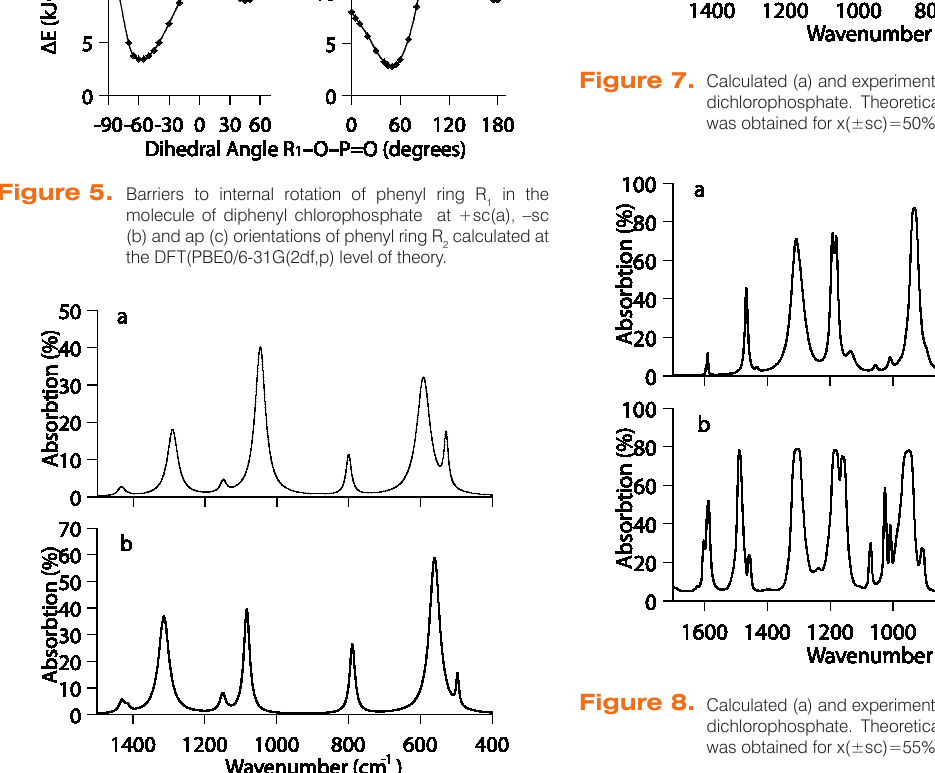
Figure 6. Calculated IR spectra of ±sc (a) and ap (b) phenyl dichlorophosphate